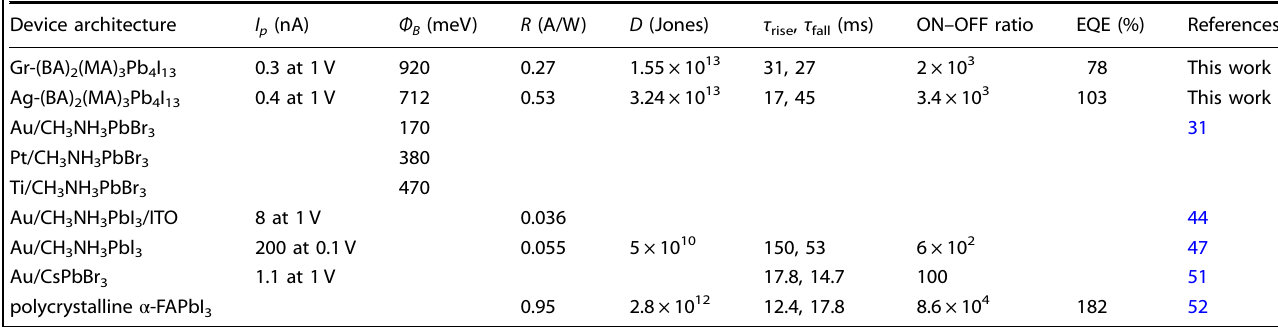
Table 1. Comparison of photocurrent I p , barrier height Φ B , photoresponsivity R , detectivity D , rise time τ rise and fall time τ f all , ON – OFF ratio, and external quantum ef fi ciency (EQE) of Gr-perovskite and Ag-perovskite fl exible PDs at room T . Device